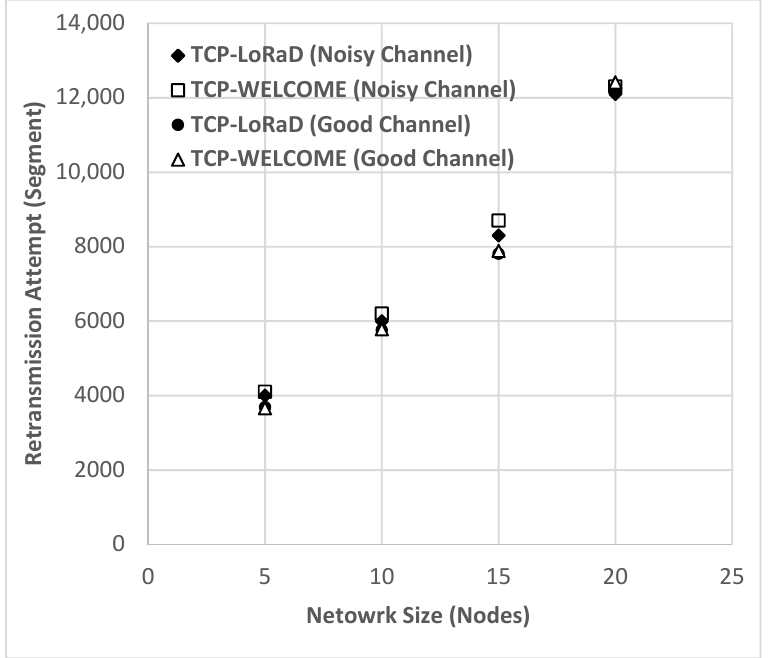
Figure 8. Retransmission attempt versus increasing number of nodes in a noisy channel. Comparison of TCP-LoRaD and TCP-WELCOME.